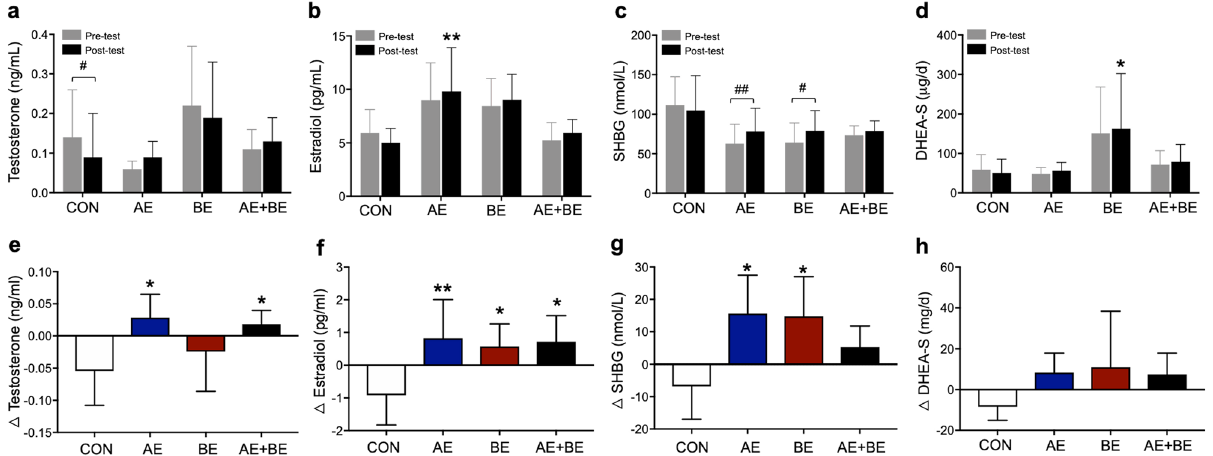
Figure 2. Effects of 16-week aquatic exercise (AE) and burdock root extract (BE) interventions on serum sex hormones. ( a ) Testosterone levels in the control (CON) group were decreased after the 16-week intervention period ( # p < 0.05). ( b ) The post-test levels of estradiol were higher in AE ( ** p < 0.01) compared to the CON group. ( c ) Sex hormone-binding globulin (SHBG) levels were increased in both AE ( ## p < 0.01) and BE subjects ( # p < 0.05), but not in the AE + BE group. ( d ) The post-test levels of dehydroepiandrosterone sulfate (DHEA-S) were higher in the BE than in the CON group (* p < 0.05). ( e ) A significant increase in the delta (Δ) value of testosterone was observed in the AE and AE + BE groups compared to the CON group ( * p < 0.05). ( f ) A significant increase in the delta (Δ) value of estradiol was detected in AE ( ** p < 0.01), BE ( * p < 0.05), and AE + BE women ( * p < 0.05) compared to CON women. ( g ) A significant increase in the delta (Δ) value of SHBG was observed in the AE and BE groups compared to the CON group ( * p < 0.05). ( h ) No significant changes in DHEA-S levels were observed between the groups. Data are presented as mean ±